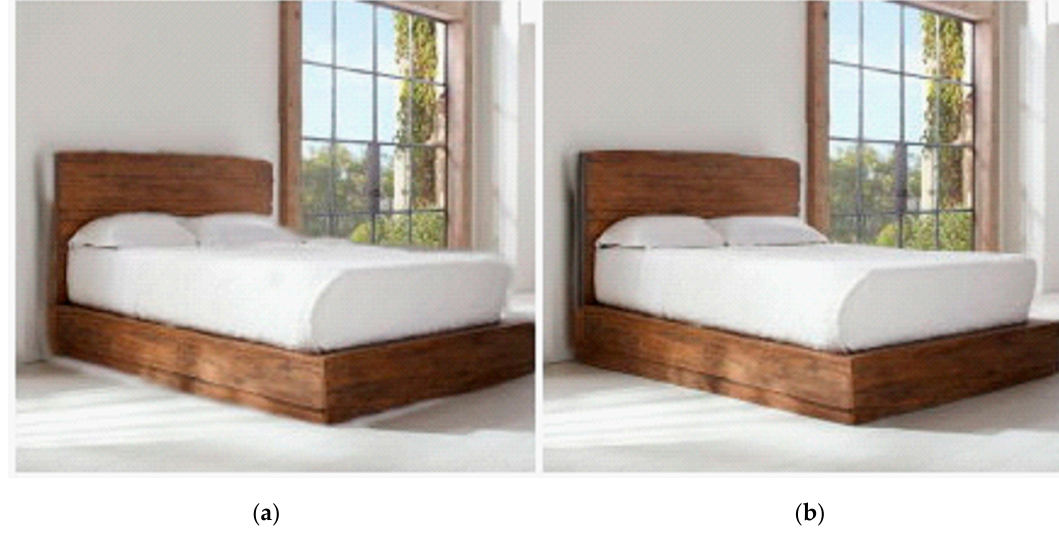
Figure 6. An improvement of the inpainting method proposed by Kawai et al. ( a ) The result using the method of Kawai et al., ( b ) the result using our improved method.